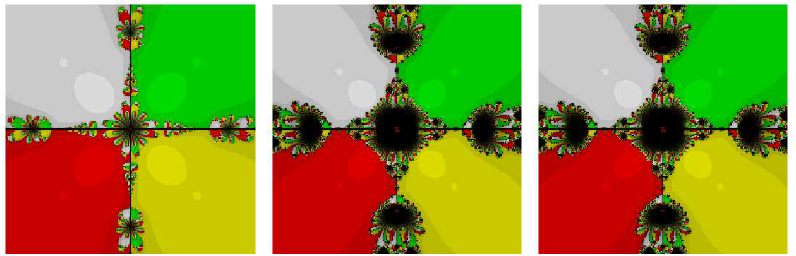
Figure 1. The methods M 1 , M 2 and M 3 , respectively for test problem